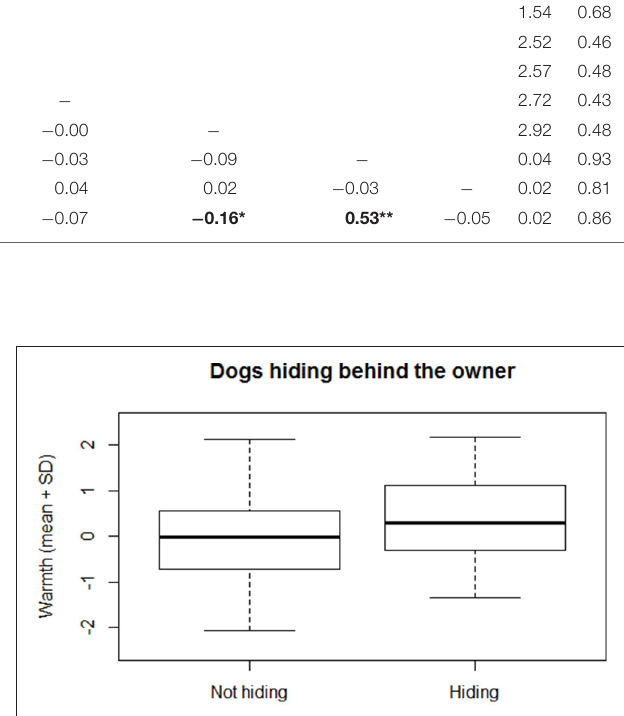
FIGURE 3 | Mean and standard deviation ( SD ) of the factor “O wner Warmth ” in dogs who hid or did not hide behind the owner during the Threatening approach